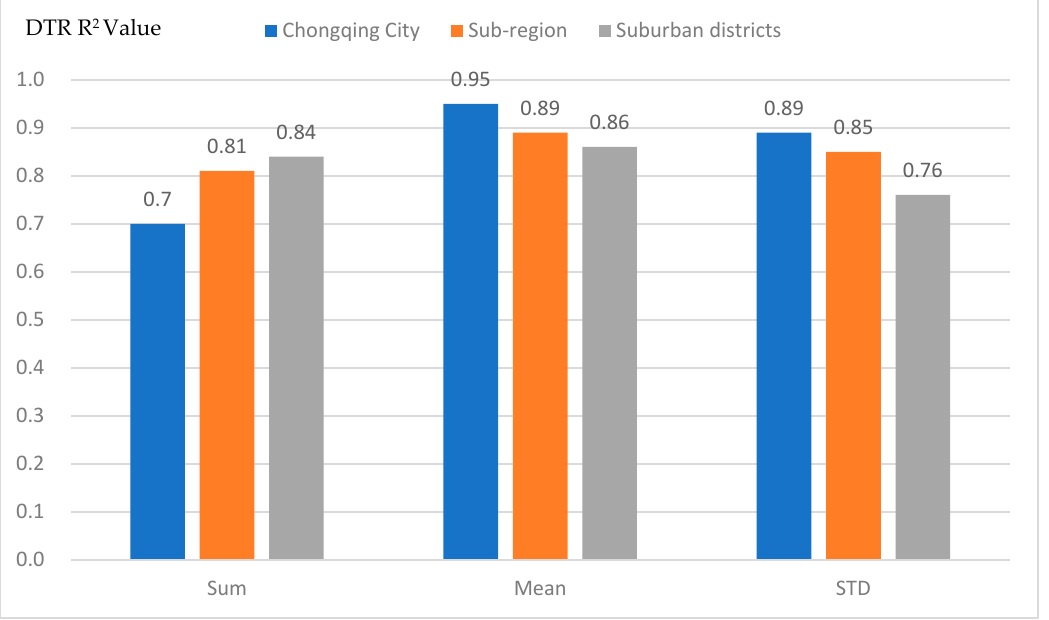
Figure 17. The three DTR-regenerated R 2 values between NTL indices and socioeconomic factors at three scales.